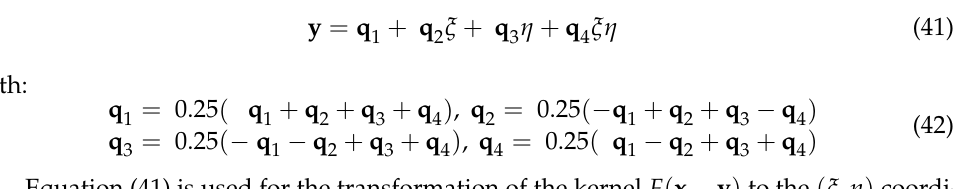
Figure 7. Transformation of the boundary element E j from the Cartesian coordinate system ( x , y , z ) to the local curvilinear system ( ξ , η ) .